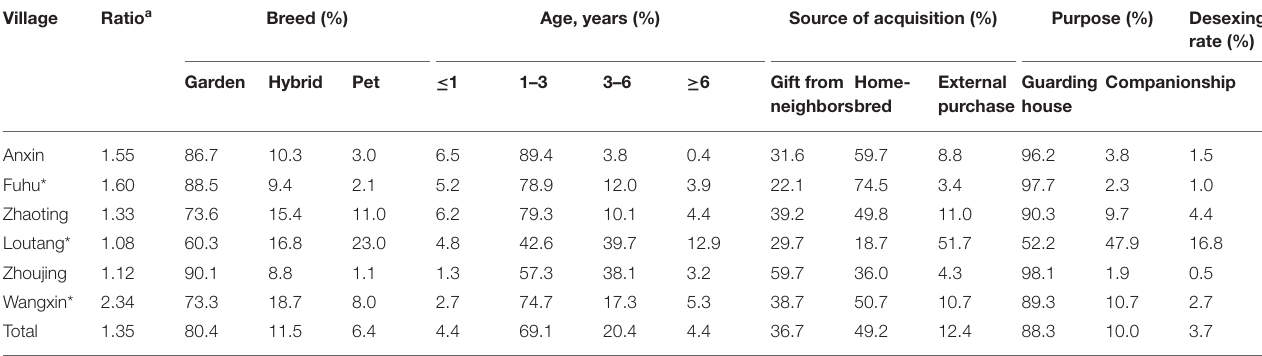
TABLE 3 | Demographic profile of owned dogs in selected model and non-model villages in Jiading district, Shanghai, 2020. Village Ratio a Breed (%) Age, years (%) Source of acquisition (%) Purpose (%) Desexing Garden Hybrid Pet ≤ 1 1–3 3–6 Gift from neighborsHome-